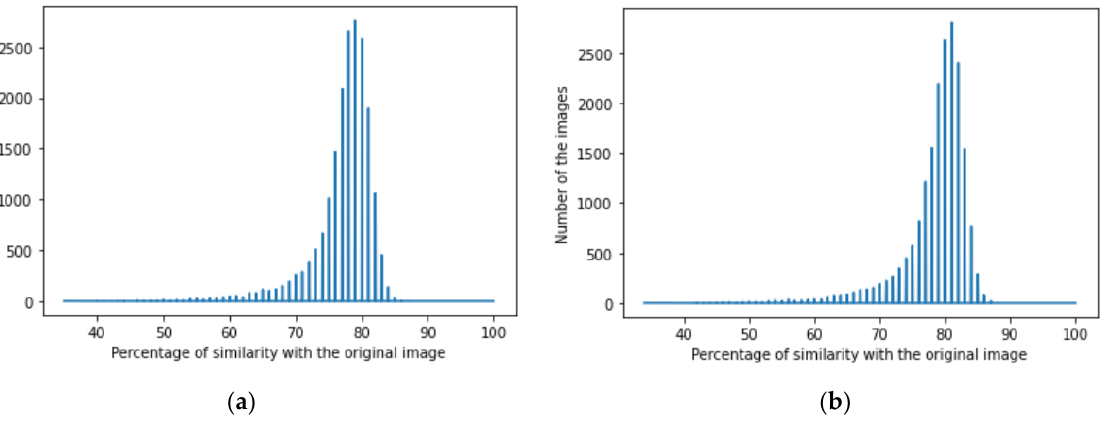
Figure 11. The histogram of similarity between the predicted denoised image and the original image in the case of impulse noise: ( a ) one autoencoder with convolutional neural networks; ( b ) dual autoencoder with convolutional neural networks.